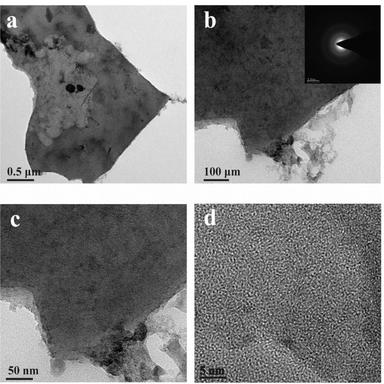
(a–d) TEM patterns of the SPCM. The illustration inside (b) was the electron diffraction of the corresponding selection.